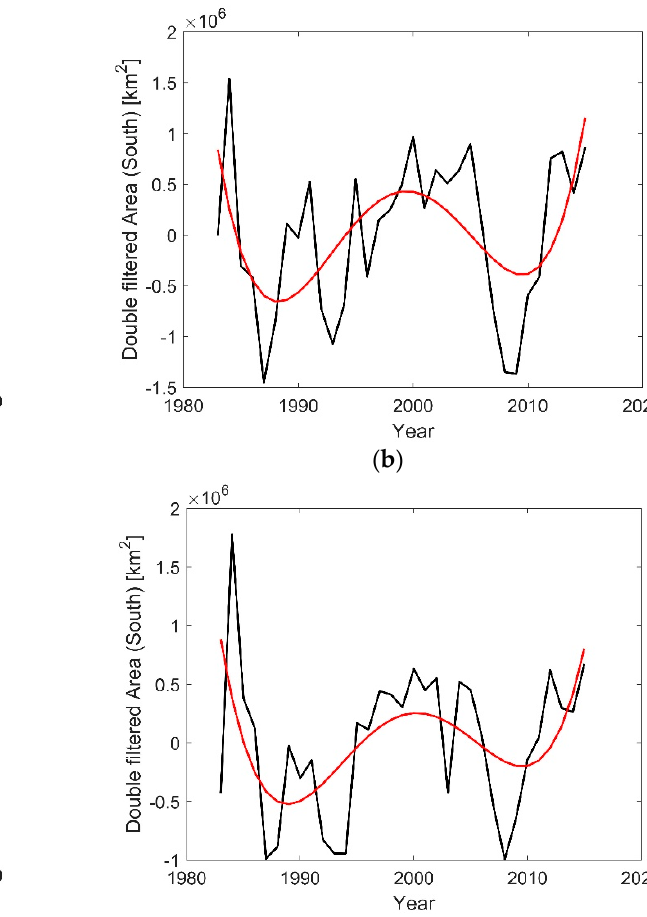
Figure 7. Northern hemisphere auroral outer boundary enclosed area A (km 2 ) time variation considering AB data with QC = 1 and 2 after filtering secular solar activity variation (black lines), and 4th-order polynomial fits (red lines), from the following filtered data series: AB data converted to A for 0 < Kp ≤ 2 ( a ), 2 < Kp ≤ 4 ( b ), 4 < Kp ≤ 6 ( c ), annual means of AB converted to A residuals from the linear regression with Kp ( d ). Note the different scales.